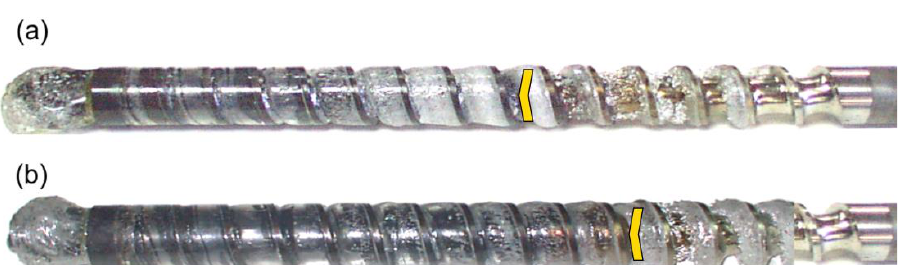
An effect of the back pressure (P back = 0 MPa, P back = 2 MPa, P back = 3 MPa) on the polymer flow in the injection molding process at the constant screw speed and the con- Figure 15. An effect of the plastication stroke on the polymer flow in the injection molding process stant plastication stroke is shown in Figures 16 – 19. It is seen that when the back pressure Figure 15. An effect of the plastication stroke on the polymer flow in the injection molding process Figure 15. An effect of the plastication stroke on the polymer flow in the injection molding process Figure 15. An effect of the plastication stroke on the polymer flow in the injection molding process Figure 15. An effect of the plastication stroke on the polymer flow in the injection molding process at at the screw speed N = 300 rpm, and the back pressure P back = 3 MPa: ( a ) h plast = 1 D, ( b ) h plast = 3 D. at the screw speed N = 300 rpm, and the back pressure P back = 3 MPa: ( a ) h plast = 1 D, ( b ) h plast = 3 D. increases, the starvation decreases. at the screw speed N = 300 rpm, and the back pressure P back = 3 MPa: ( a ) h plast = 1 D, ( b ) h plast = 3 D. at the screw speed N = 300 rpm, and the back pressure P back = 3 MPa: ( a ) h plast = 1 D, ( b ) h plast = 3 D. the screw speed N = 300 rpm, and the back pressure P back = 3 MPa: ( a ) h plast = 1 D, ( b ) h plast = 3 D.